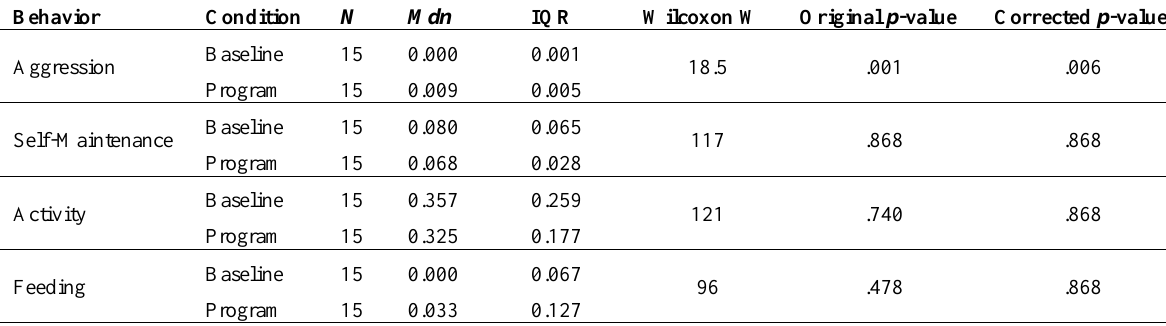
Results of Comparisons of Behavior after the Program and Matched Control